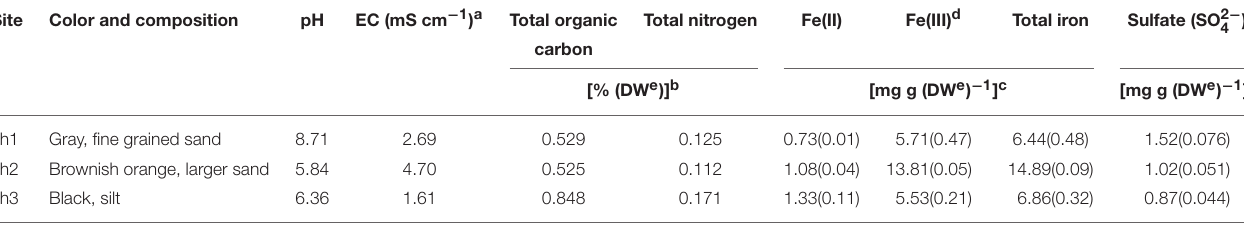
TABLE 1 | Physico-chemical characteristics of the sediment samples. Site Color and composition